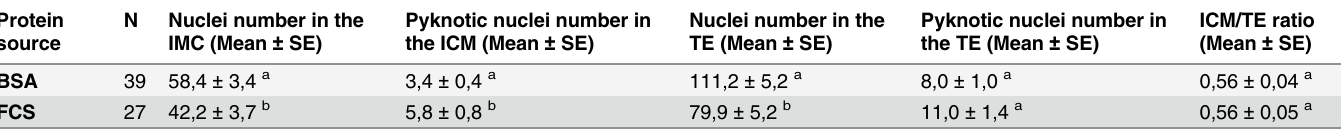
Table 3. Nuclei number in the ICM and TE from hatched blastocysts 9 days after IVF (Be — D9) classi fi ed according to the sources of protein (BSA or FCS). Protein source